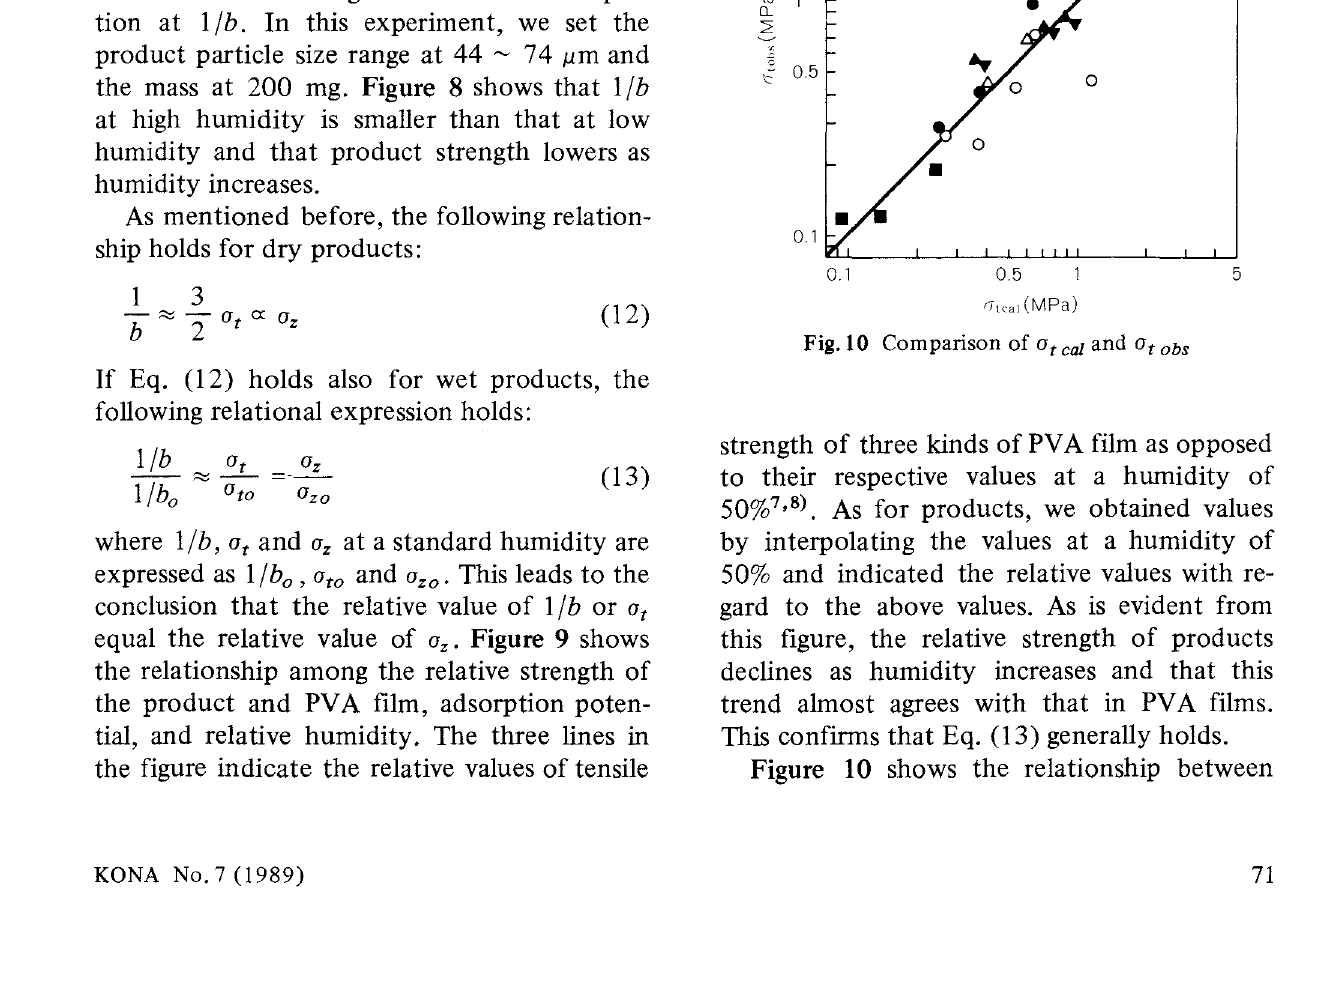
Fig. 9 Influence of relative humidity on strength of products 5 Keys . same as shown rn Fro.9